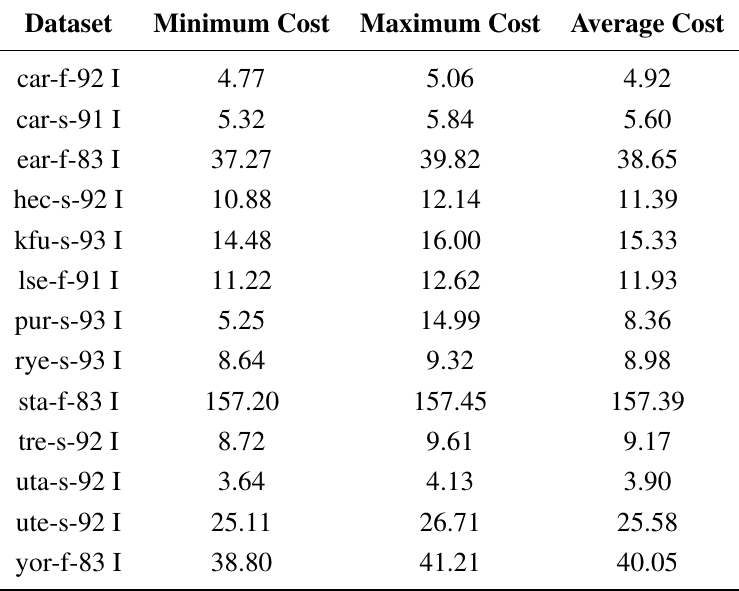
Table 9. Minimum, maximum and average cost with a population size of 16,384.